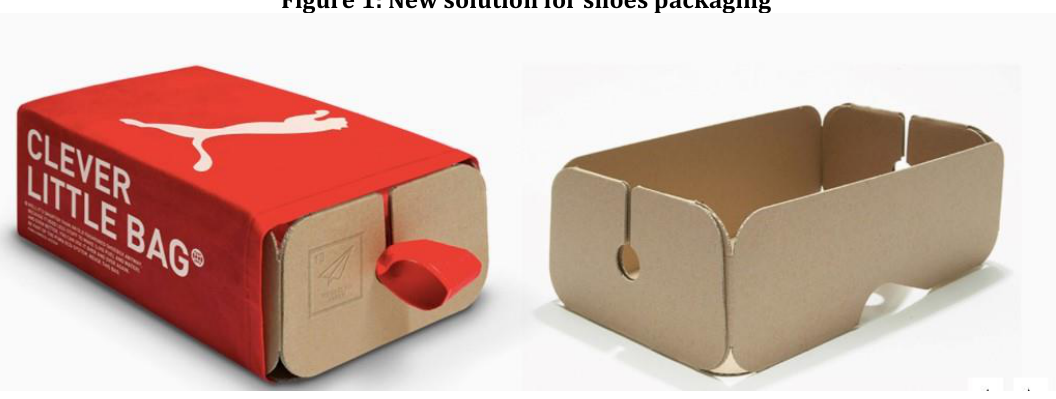
Figure 1: New solution for shoes